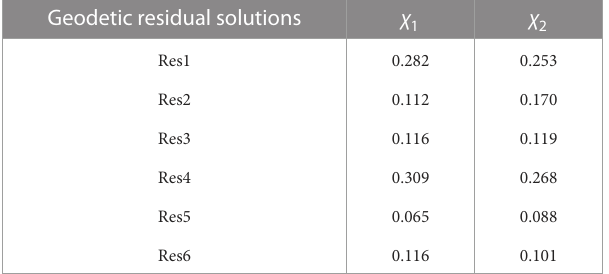
TABLE2 Weightsforsixdifferentgeodeticresidualtimeseriesdetermined